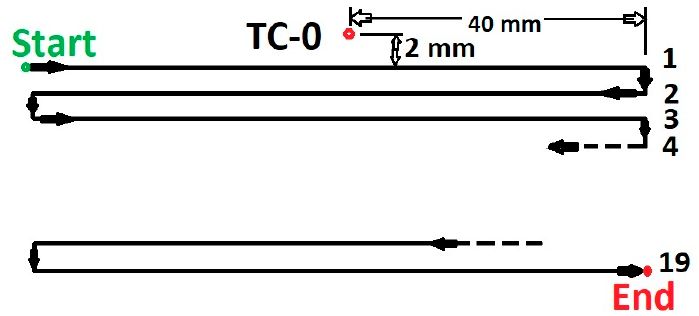
Figure 8. Scanning strategy and thermocouple position for multi-track deposition.